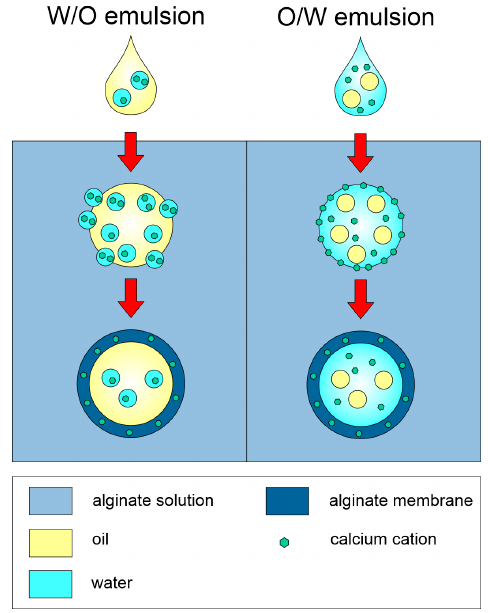
Figure 1. Reverse gelation scheme depending on emulsion type used.